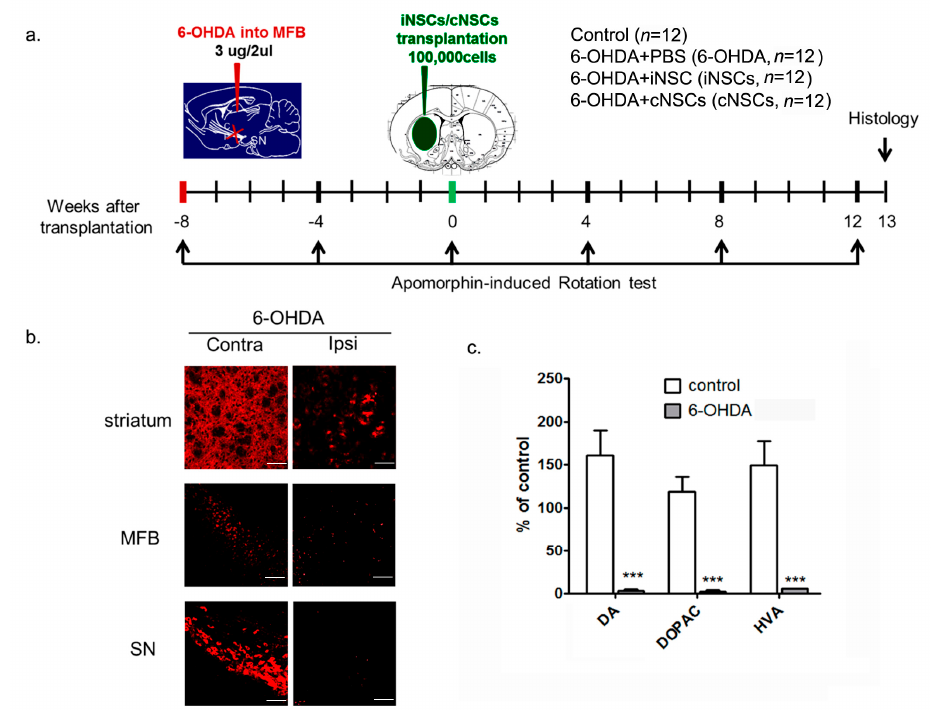
Figure 2. The timeline of the experiment and animal models. ( a ) Three micrograms of 6-hydroxydopamine (6-OHDA) were unilaterally injected into the medial forebrain bundle (MFB). Eight weeks later, saline (6-OHDA), induced neural stem cells (iNSCs, 6-OHDA + iNSCs), or control neural stem cells (cNSCs, 6-OHDA + cNSCs) were injected into the ipsilateral striatum. Control, 6-OHDA, 6-OHDA + iNSCs, and 6-OHDA + cNSCs mice were evaluated using the apomorphine-induced rotation behavior test at intervals of four weeks after 6-OHDA injection. All animals were used for behavioral analysis and histological studies; ( b ) representative photomicrographs of tyrosine hydroxylase (TH) staining in the mouse striatum, MFB, and SN sections. Three micrograms of 6-OHDA were injected into the MFB. Eight weeks later, DA neurons in the striatum, MFB, and substantia nigra (SN) were visualized with TH immunostaining. Scale bars = 50 µ m; ( c ) dopaminergic (DA), 3,4-dihydroxyphenylacetic acid (DOPAC), and homovanillic acid (HVA) levels were determined in the stratum at eight weeks after 6-OHDA injected into the MFB. Results are presented as the mean ± SEM, n = 6. *** p < 0.001 vs. control.